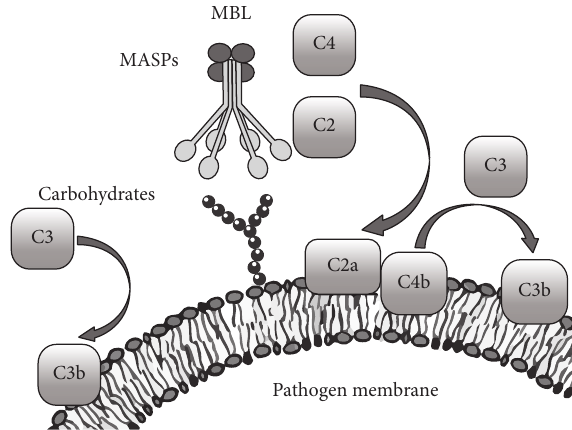
Figure 4: A model illustrates the activation of the lectin pathway by infective agents. MBL recognizes specific carbohydrates such as D- mannose, L-fucose, and N-acetylglucosamine that are represented on the surface of a wide variety of infectious agents. Engagement of ligand by MBL activates MASP2, which then cleaves the C2C4 convertase and results in the cleavage of C3 and the generation of C3b. It has also been proposed that MASP1 can directly cleave C3